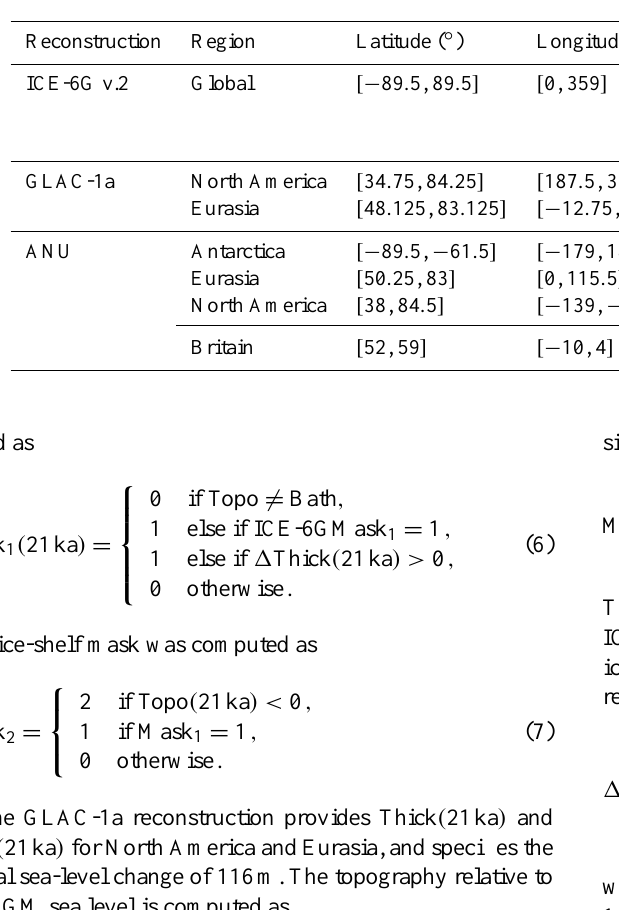
Table 1. The spatial domain and output variables provided by each of the individual ice-sheet reconstructions, ICE-6G v.2, GLAC-1a and ANU. Latitude and longitude ranges are expressed in decimal degrees, where positive indicates north and east respectively and negative indicates south and